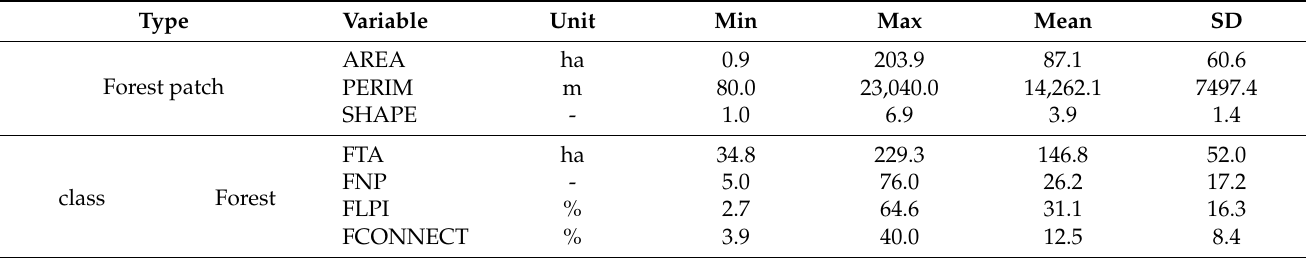
Table 3. Minimum, maximum, mean, and standard deviation (SD) values of landscape variables analyzed for Nothofagus antarctica forests in Tierra del Fuego